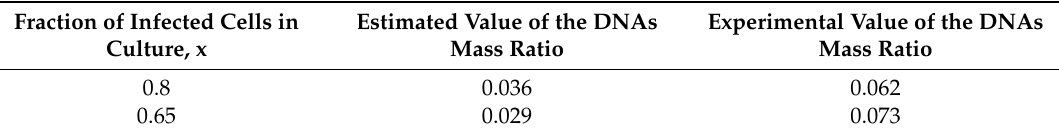
Table 1. Comparison of estimated values of the ratio of the phage DNA mass to bacterial DNA mass at 5 min after the infection